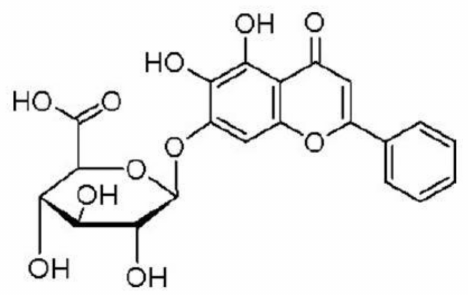
Figure 2. Molecular structure of baicalin. The IUPAC name of baicalin is (2S,3S,4S,5R,6S)-6-(5,6- dihydroxy-4-oxo-2-phenylchromen-7-yl)oxy-3,4,5-trihydroxy-tetrahydropyran-2-carboxylic acid, or also known as baicalein 7- O